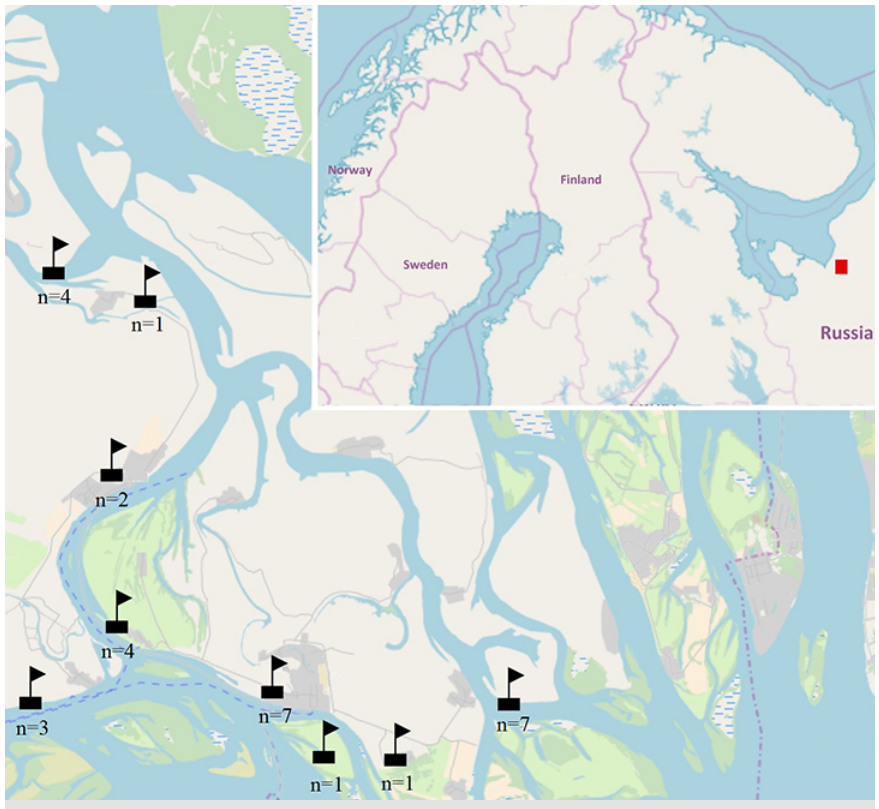
Fig. 1 Test plot locations (flagged) and amount in the Northern Dvina River